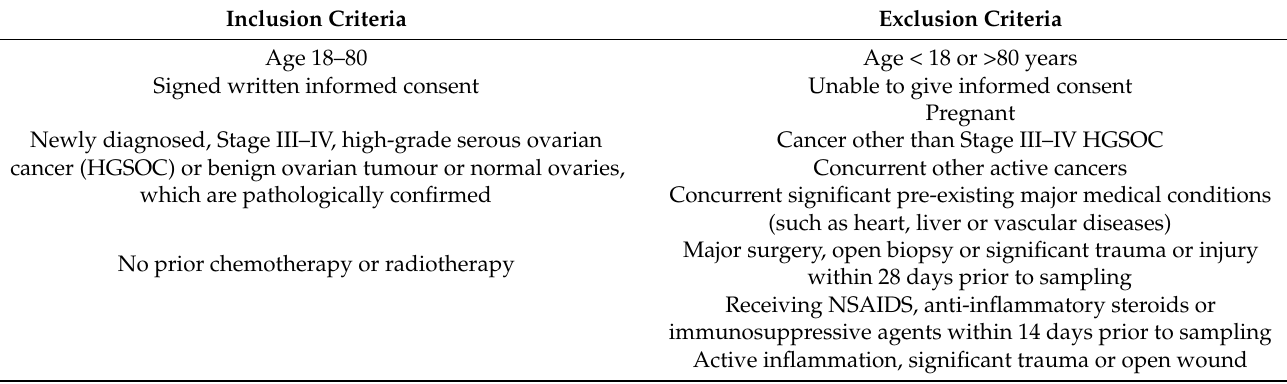
Table 1. Study inclusion and exclusion criteria.